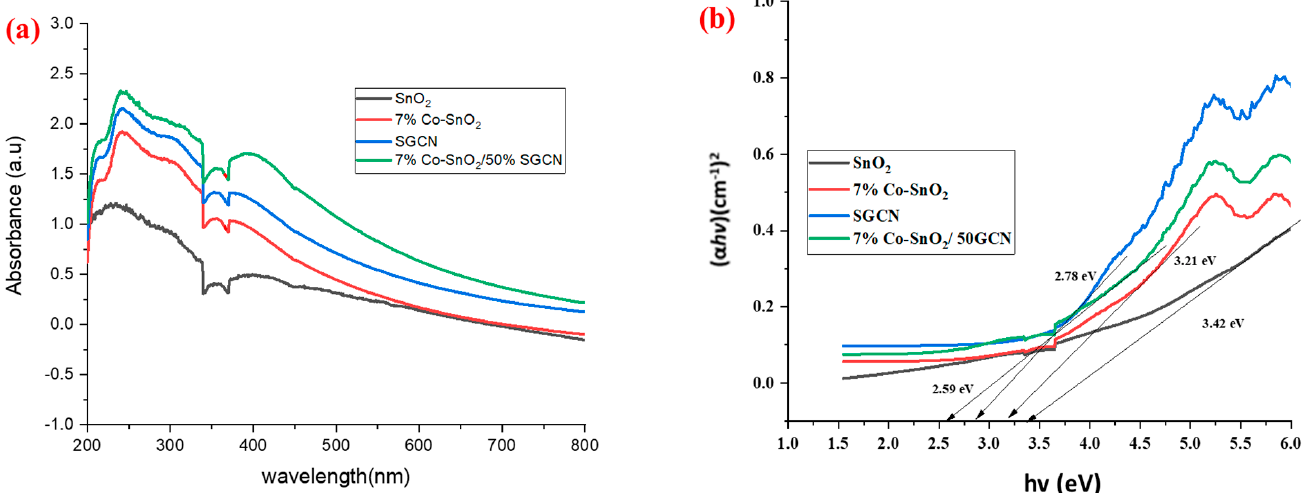
Figure 5. Absorption spectra ( a ) and bandgap of SnO 2 , 7% Co-SnO 2 , and 7% Co-SnO 2 /50% SGCN ( b ).